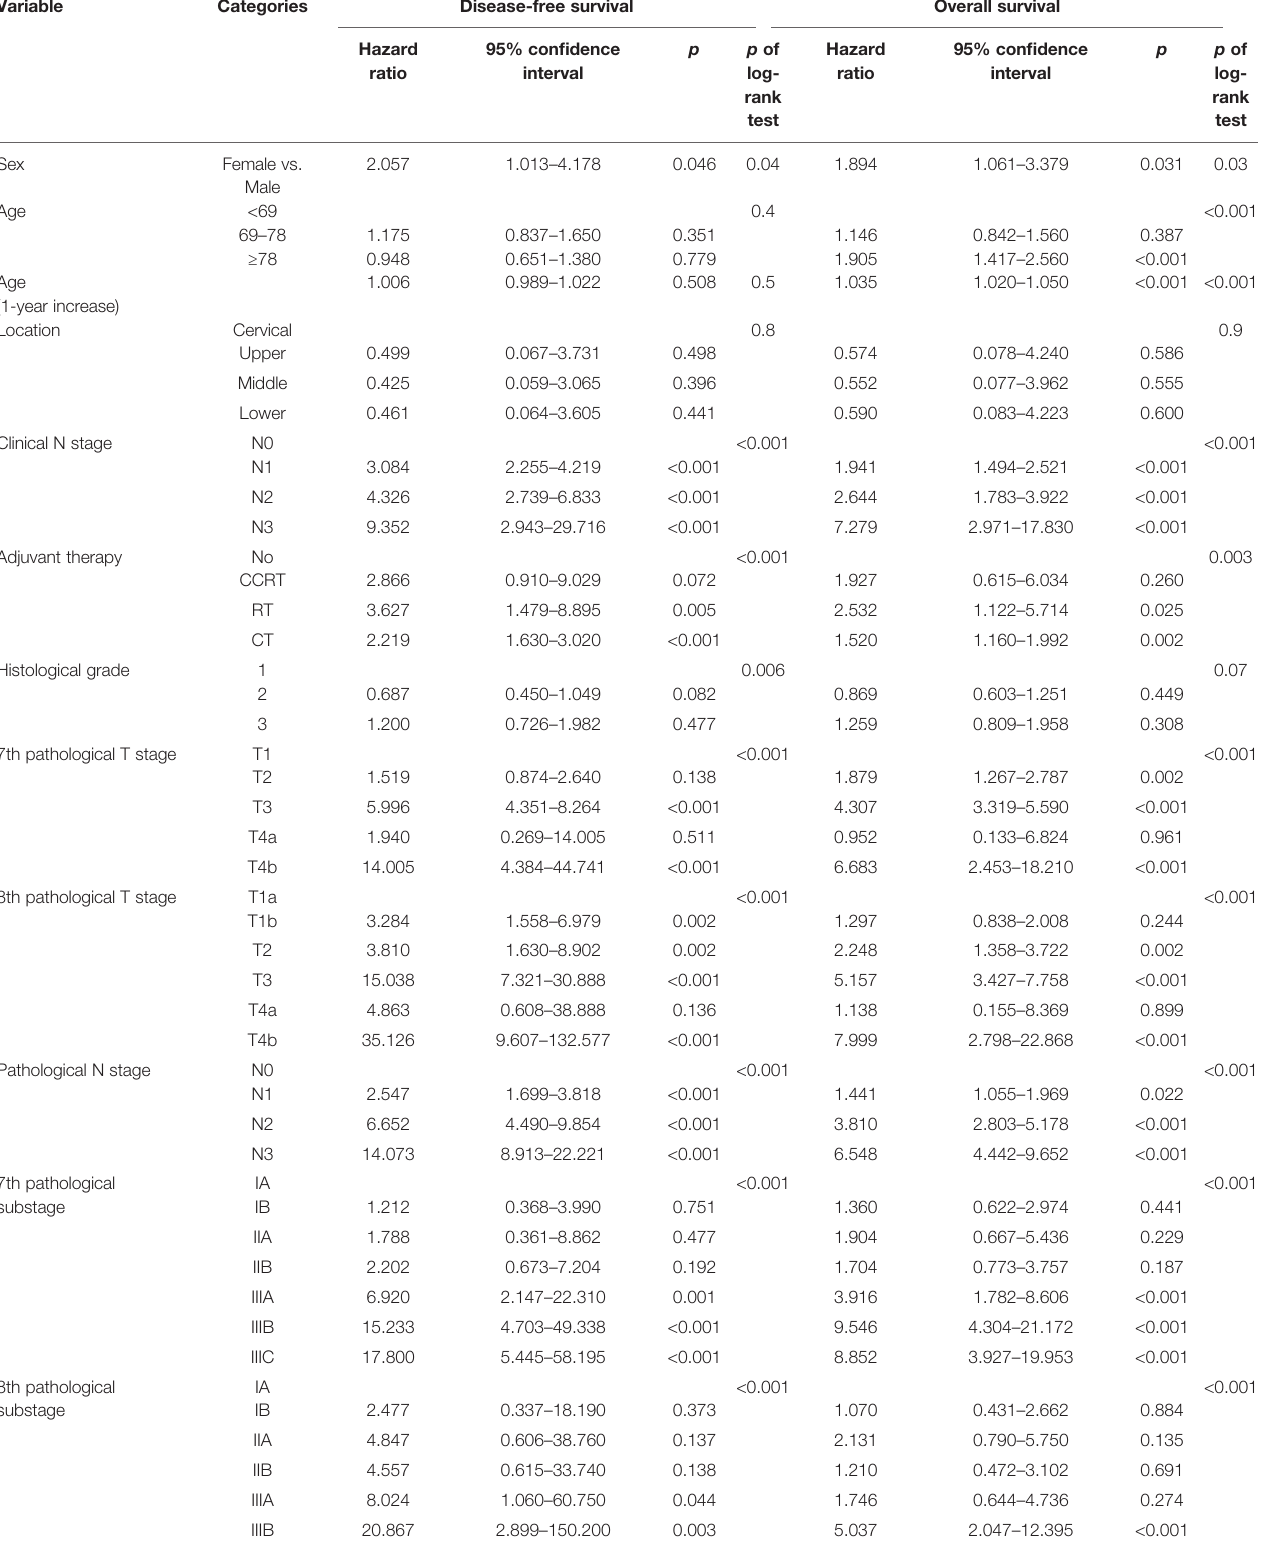
TABLE 2 | Univariate Cox regression analysis of survival in esophageal squamous cell